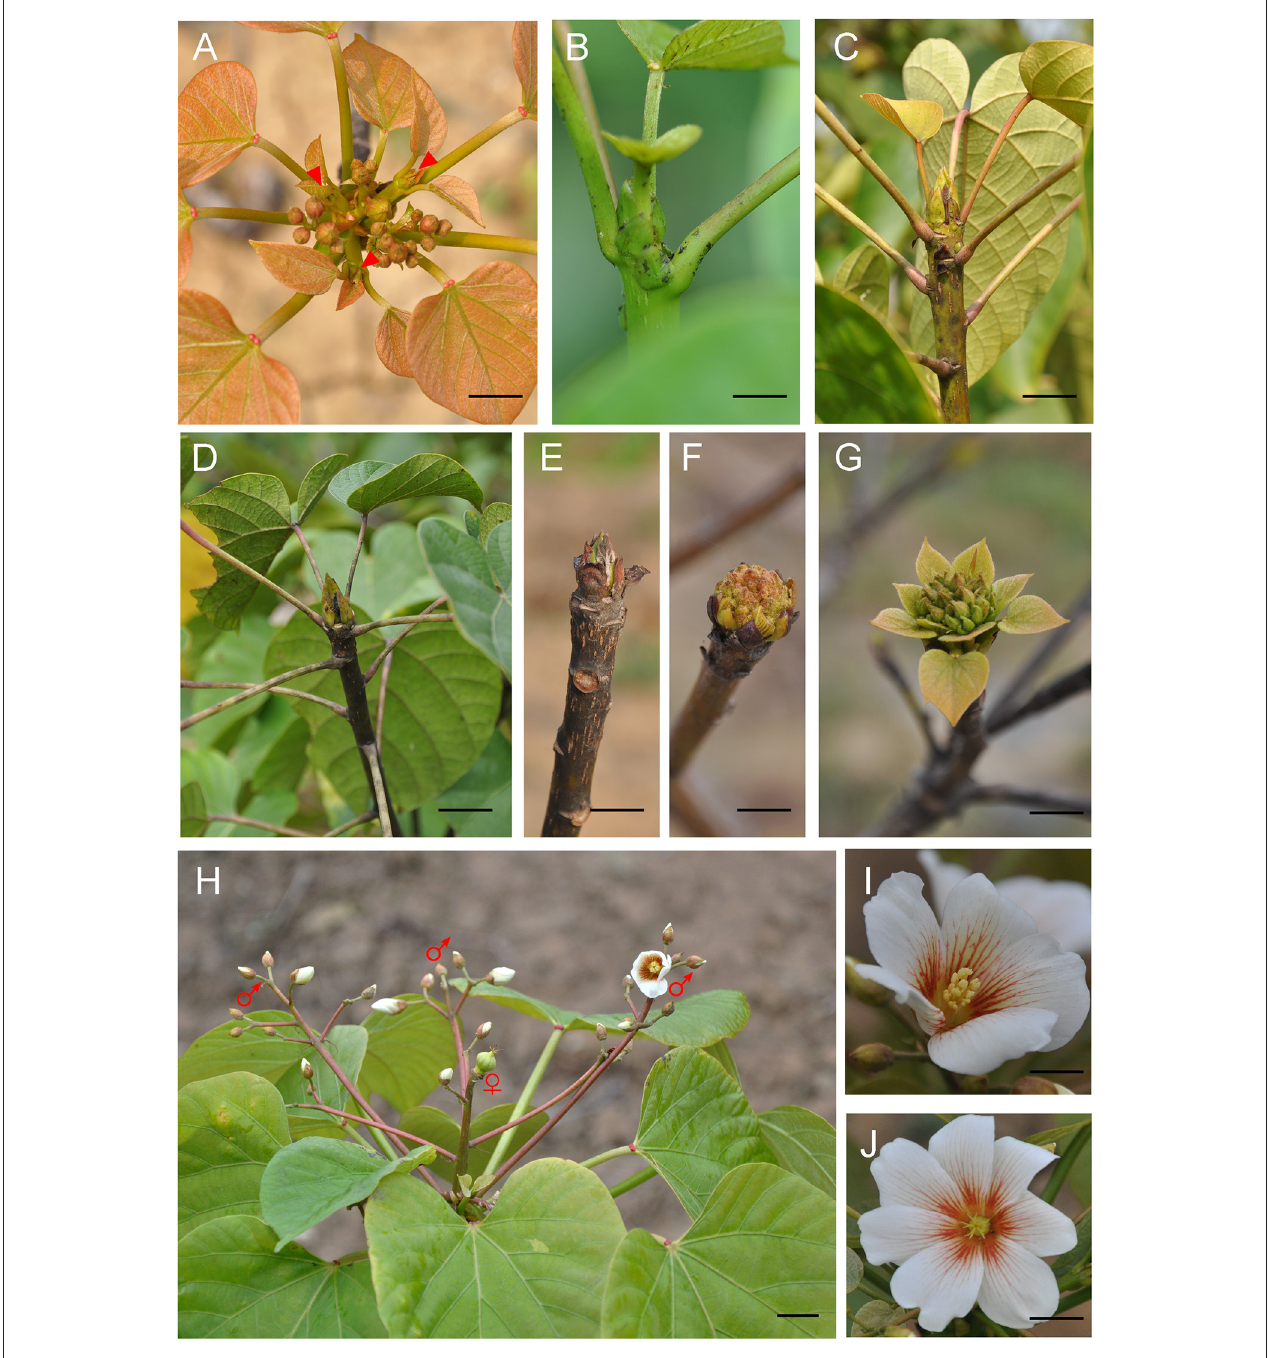
FIGURE 1 | Phenological growth stages and structure of V. fordii flower. (A) The new shoots (red arrowhead) emerged in April. (B,C) The vegetative shoots grew in May and June. (D) The inflorescence emerged in July and August. (E) The dormancy of floral buds in winter. (F) Floral bud breaking and swelling in spring. (G) The formation of cymose inflorescence (H) Structure of an inflorescence. ♀ : male flower, ♂ : female flower (petal removed). (I) The male flower. (J) The female flower. Scale bar = 1cm.